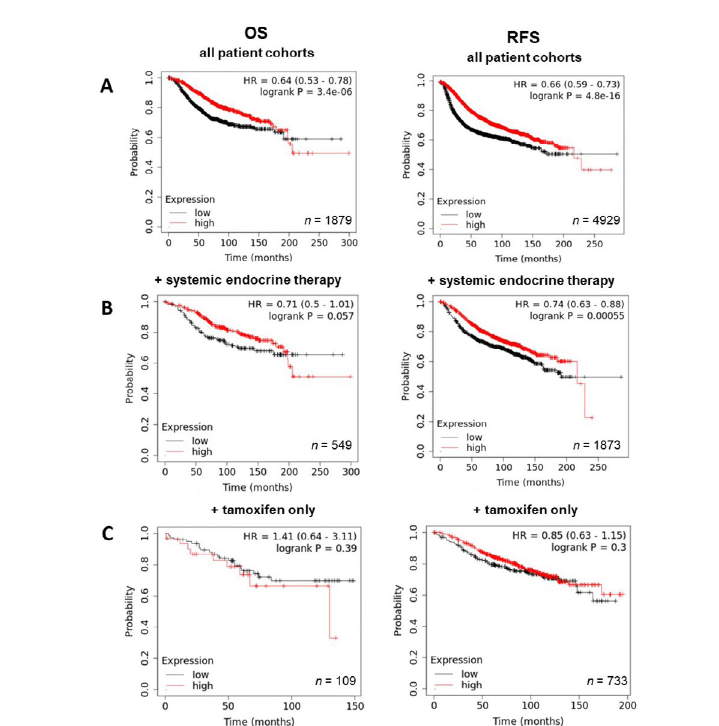
Figure 5. Kaplan-Meier plots describing ZIP6 mRNA expression relationship with OS and RFS, in breast cancer patients. All plots were generated using KmPlot [20] with expression cohorts defined by “auto-selected” cut-offs. Probe sets were optimized via “JetSet” function. Patient cohorts were progressively focused from unrestricted analysis (A), initially into those receiving systemic endocrine therapy (B), before isolating those specifically treated with tamoxifen (C). Hazard ratios (HRs) and significance values ( P ) are indicated on graphs, with the number of patients included in each analysis ( n ) noted